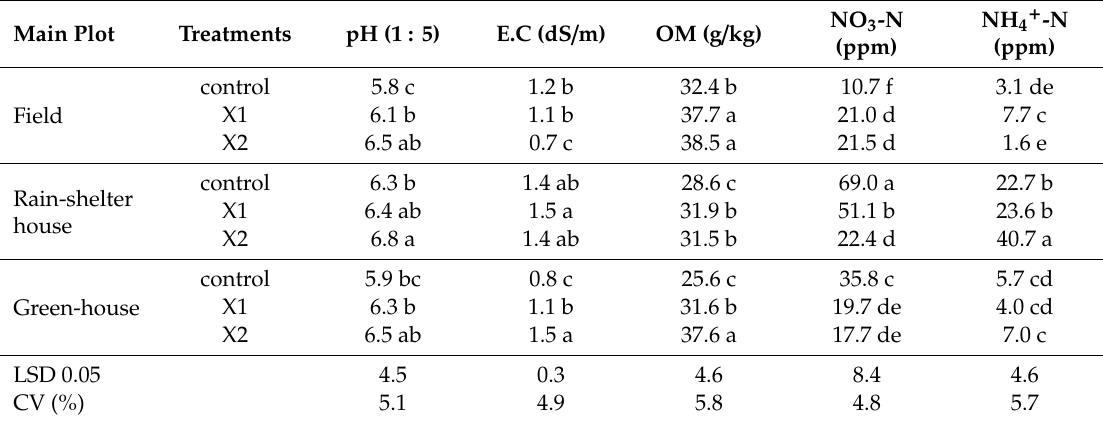
Table 9. E ff ects of di ff erent rates of organic manure application on soil chemical contents at the end of the experiment.